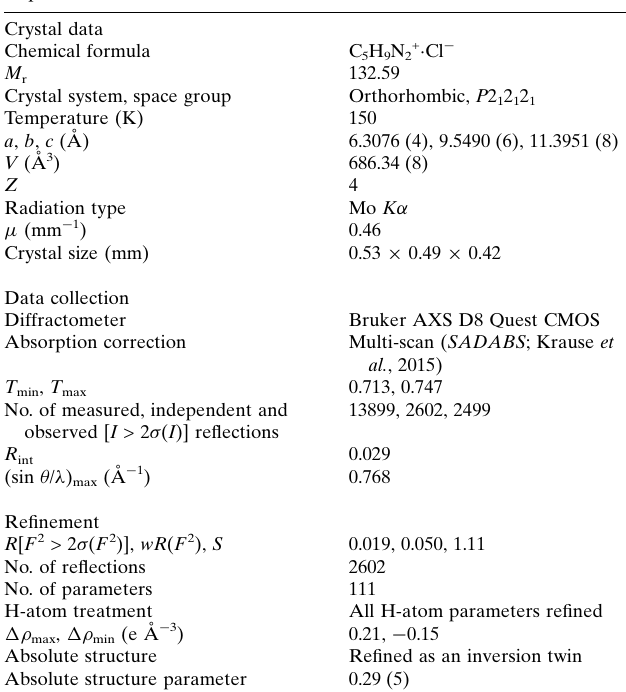
Table 2 Experimental details.